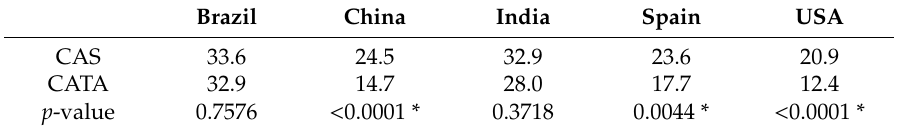
Table 7. Means 1 and p -values for the survey mean duration for CAS and CATA per country.